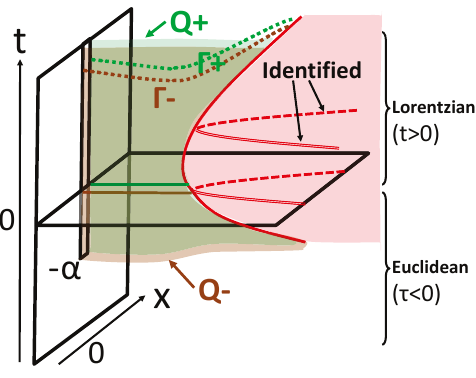
Figure 13 . The spacetime geometry of gravity dual of the splitting local quench. The green surface ( Q + ) and brown one ( Q (cid:0) ) are the boundary surface Q in the AdS/BCFT. The red region de(cid:12)ned by z > G L ( x; t ) should be removed with the dotted red curve and the doubled red curve identi(cid:12)ed. Thus this identi(cid:12)ed red region corresponds to the horizon. The region x > 0 and x < 0, which are separated at the AdS boundary z = 0 are connected (in a space-like way) through this horizon in the